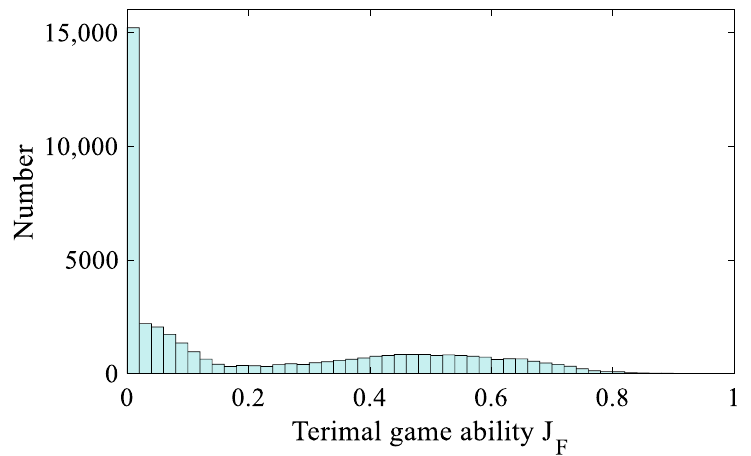
Figure 9. The J F distribution of the feasible sample scenarios for FRS.